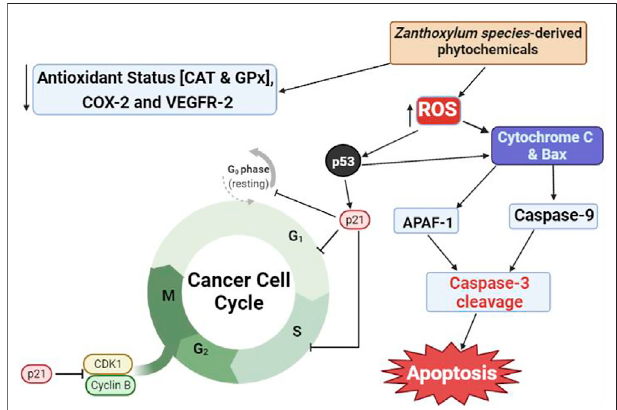
FIGURE 1 | Proposed mechanism of anticancer activities of natural products from Zanthoxylum species. CAT, catalase; GPx, glutathione peroxidase; COX-2, cyclooxygenase-2; VEGFR-2, vascular endothelial growth factor receptor-2; CDK1, cyclin-dependent kinase-1; ROS, reactiveoxygen species; Bax, Bcl-2-associated X protein; APAF-1, apoptosis protein activating